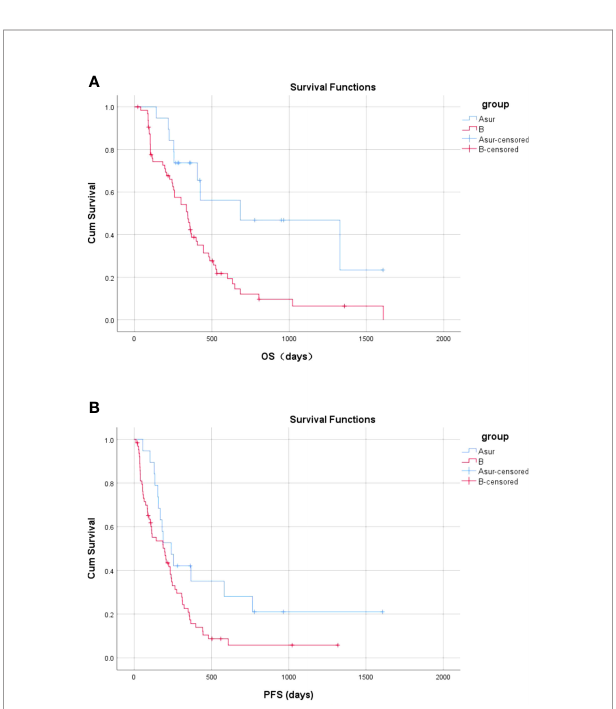
FIGURE 7 | Overall and progression-free survival between Group A Sur and Group B (A) The OS in Group A Sur and Group B (B) The PFS in the no- operative Group A Sur and Group B.